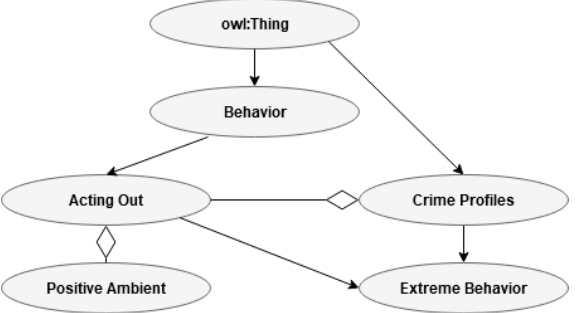
Figure 12. Relationship between acting out in one of the B’s and extreme behavior in CP.